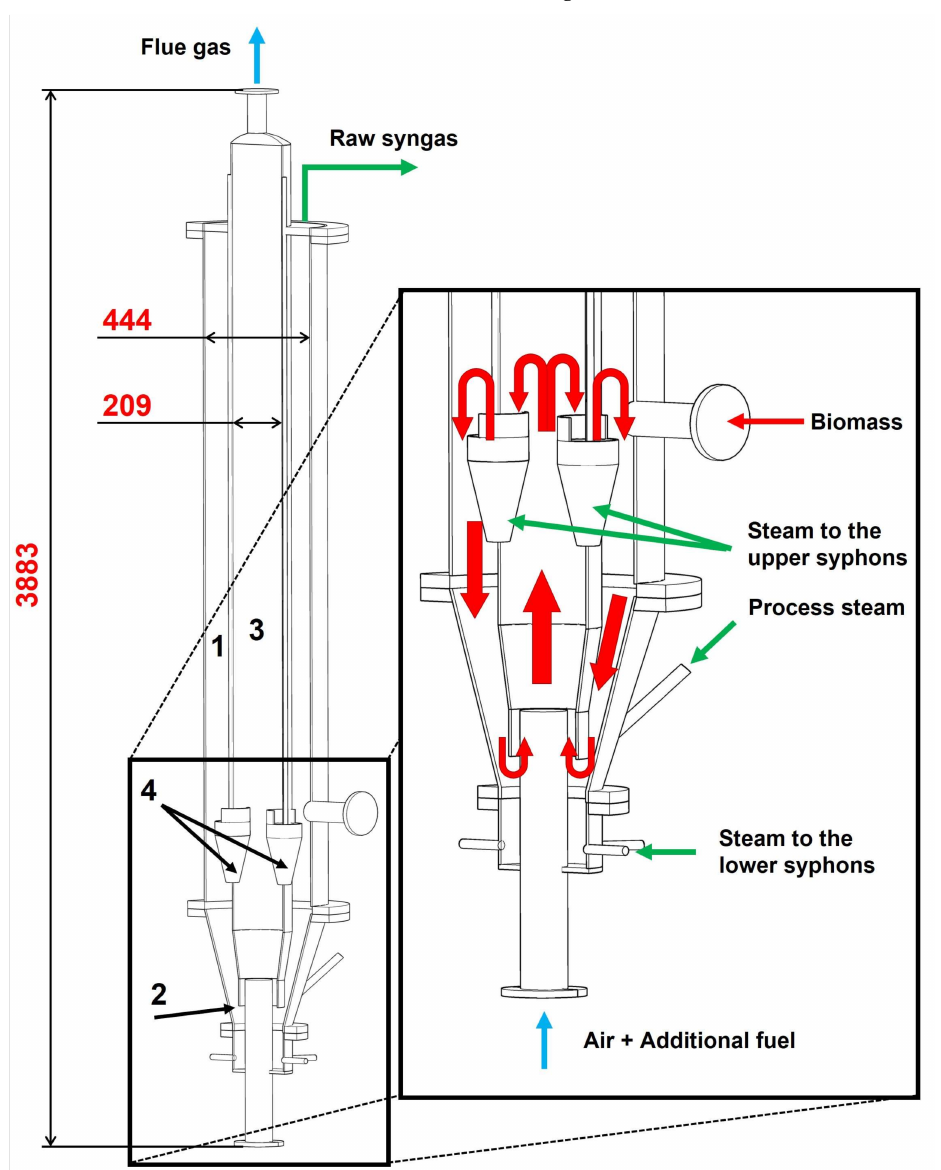
Figure 1. A 3D sketch of the new dual bubbling fluidized bed gasifier: (1) gasification chamber; (2) lower siphon; (3) combustion chamber; (4) upper